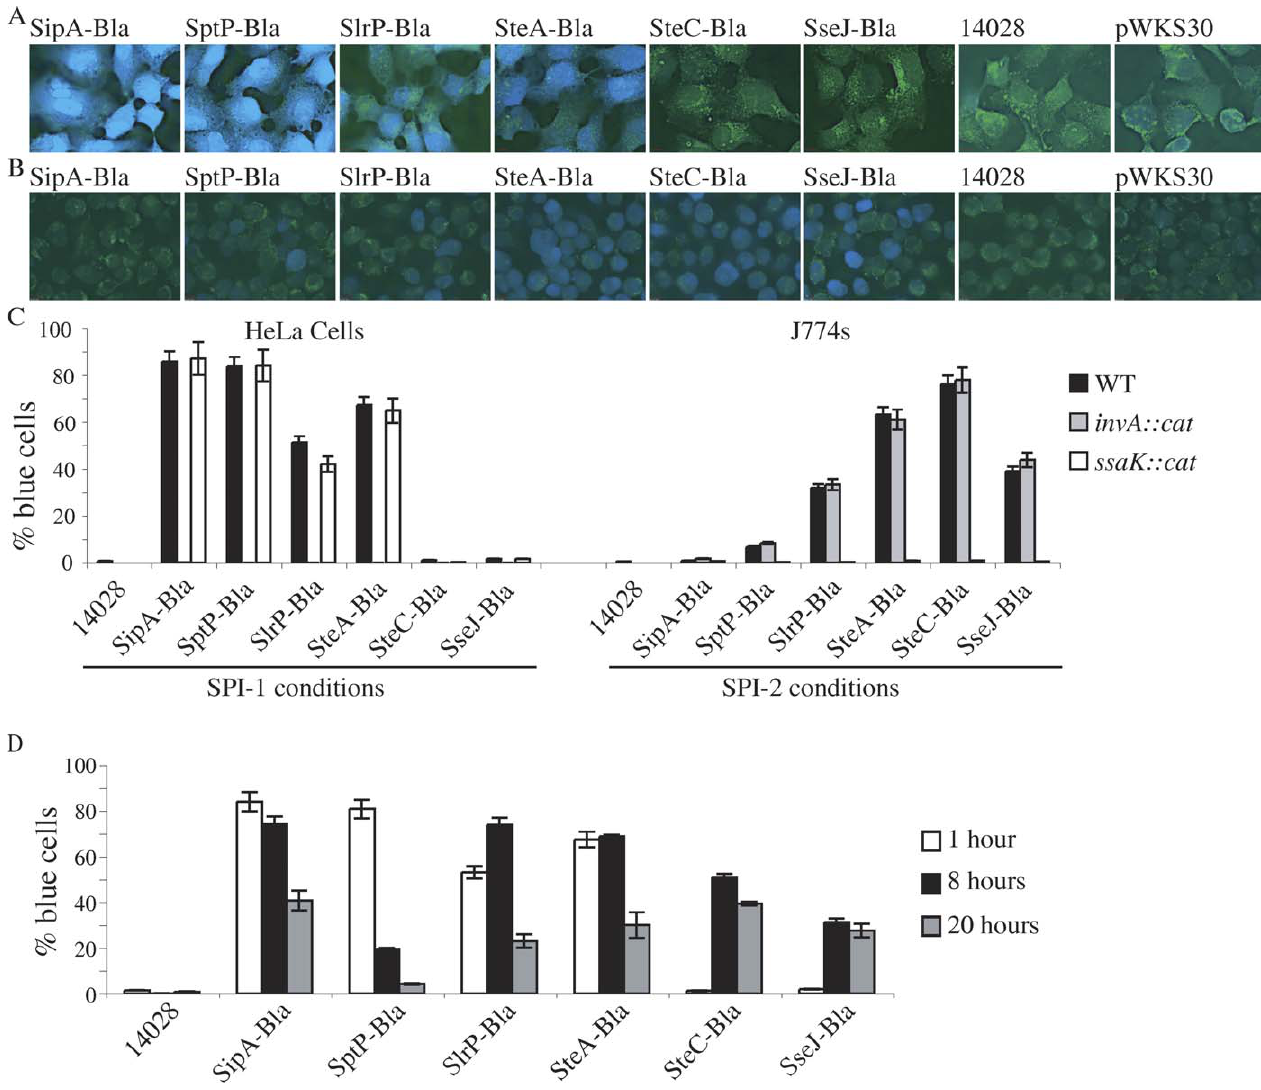
Figure 1. Visualization of Secretion in HeLa Cells (A) and J774s (B) by Microscopy (60 3 Magnification) S. typhimurium 14028 strains expressing Bla fusions to SipA, SptP, SlrP, SteA, SteC, and SseJ; WT 14028, or 14028 harboring pWKS30 were used to infect HeLa cells for 2 hours using SPI-1-inducing conditions and J774s for 10 hours using SPI-2- inducing conditions. Following the infections, cells were loaded with CCF2-AM and visualized for green and blue fluorescence by microscopy. Green fluorescence indicates CCF2-AM was loaded and the presence of blue cells is evidence of secretion. SPI-1 TTSS- and SPI-2 TTSS-dependent secretion detected by FACS analysis (C). HeLa cells and J774s were infected as described above with the six effector-Bla fusions that were expressed in WT 14028, invA :: cat and ssaK :: cat backgrounds, mutations in structural components of SPI-1 and SPI-2 TTSS, respectively. FACS analysis was performed on CCF2-AM loaded cells to determine the percentage of blue cells (positive for secretion). Background percentage of blue cells was set using WT 14028–infected cells. At least 10,000 cells were analyzed for each sample. Each bar represents the mean percentage of blue cells from triplicate samples and the error bars are 6 one standard error of the mean. FACS analysis was also performed on HeLa cells infected with each Bla fusion strain for 1, 8, or 20 hours using SPI-1 inducing conditions (D).